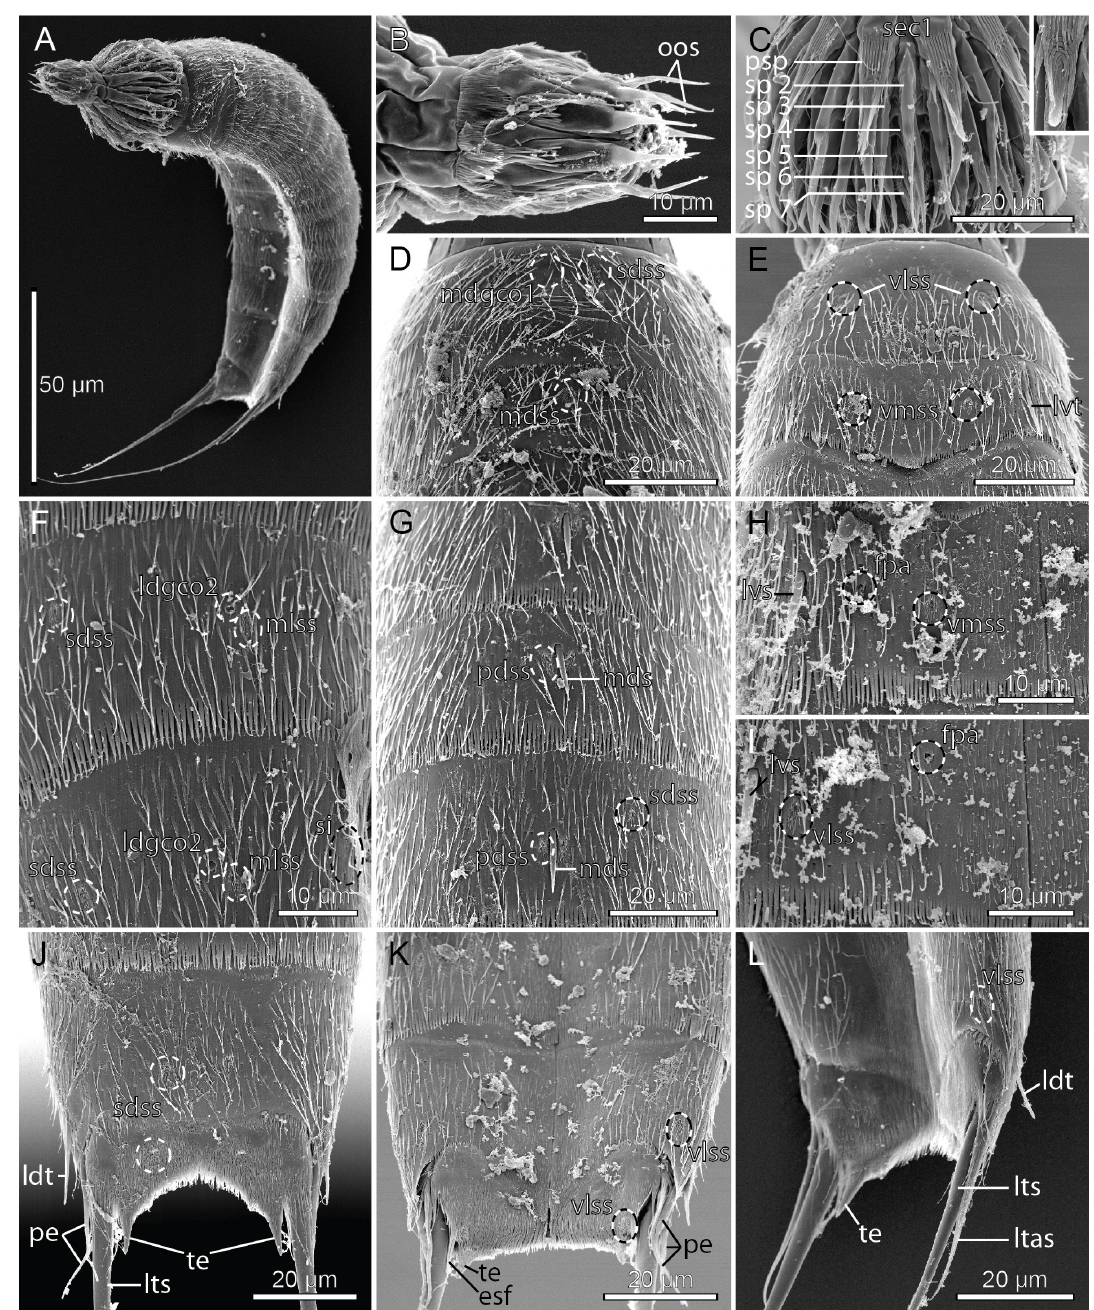
Fig. 24. Scanning electron micrographs showing overviews and details of Echinoderes chandrasekharai Sørensen & Chatterjee sp. nov. A–C, H–I, K . ♀ (MVS, personal reference collection). D–G, J, L . ♂ (MVS, personal reference collection). A . Ventrolateral overview. B . Mouth cone, lateroventral view. C . Introvert sector 1 (ventral); inset shows detail of primary spinoscalid fringes, alternatingly attaching along a longitudinal line. D . Segments 1 to 2, dorsal view. E . Segments 1 to 2, ventral view. F . Segments 8 to 9, lateral view. G . Segments 6 to 8, dorsal view. H . Right sternal plate of segment 7, showing female sexual dimorphism. I . Right sternal plate of segment 8, showing female sexual dimorphism. J . Segments 10 to 11 dorsal view, showing male sexual dimorphism. K . Segments 10 to 11 ventral view, showing male sexual dimorphism. L . Segments 10 to 11 ventrolateral view, showing female sexual